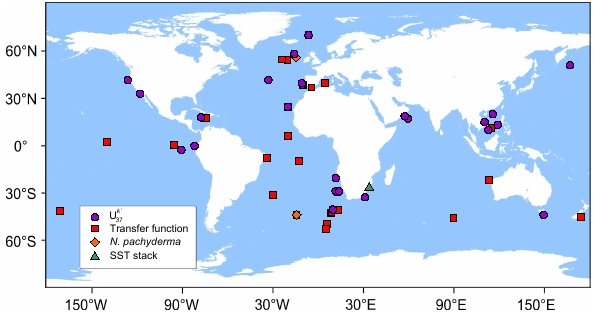
Fig. 1. Position of the sea surface temperature (SST) records used in this study. The compilation contains SST records based on Mg/Ca, 0 U k , transfer functions (TFs) including an artificial neural network 37 (ANN), scaling of oxygen isotopes values in Neogloboquadrina pachyderma and percentages of N. pachyderma (see Sect. 2.1), and one SST stack based on the mean of Mg/Ca, U k ble